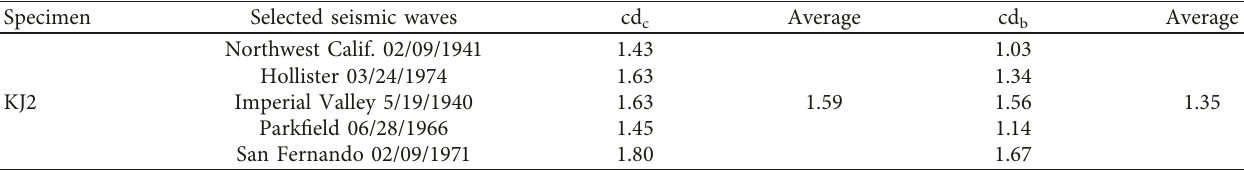
Table 13: Maximum curvature ductility coefficients of beams and columns in model KJ2.